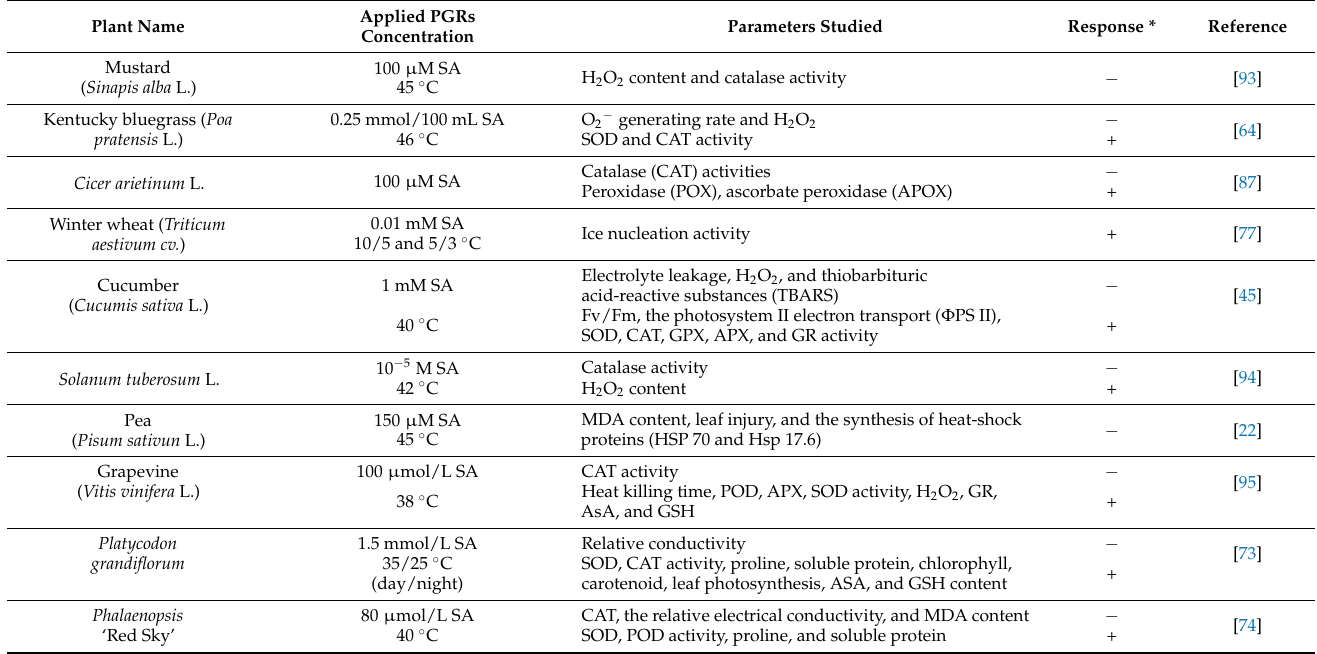
Table 1. Enhanced temperature resistance upon exogenous PGR application in different